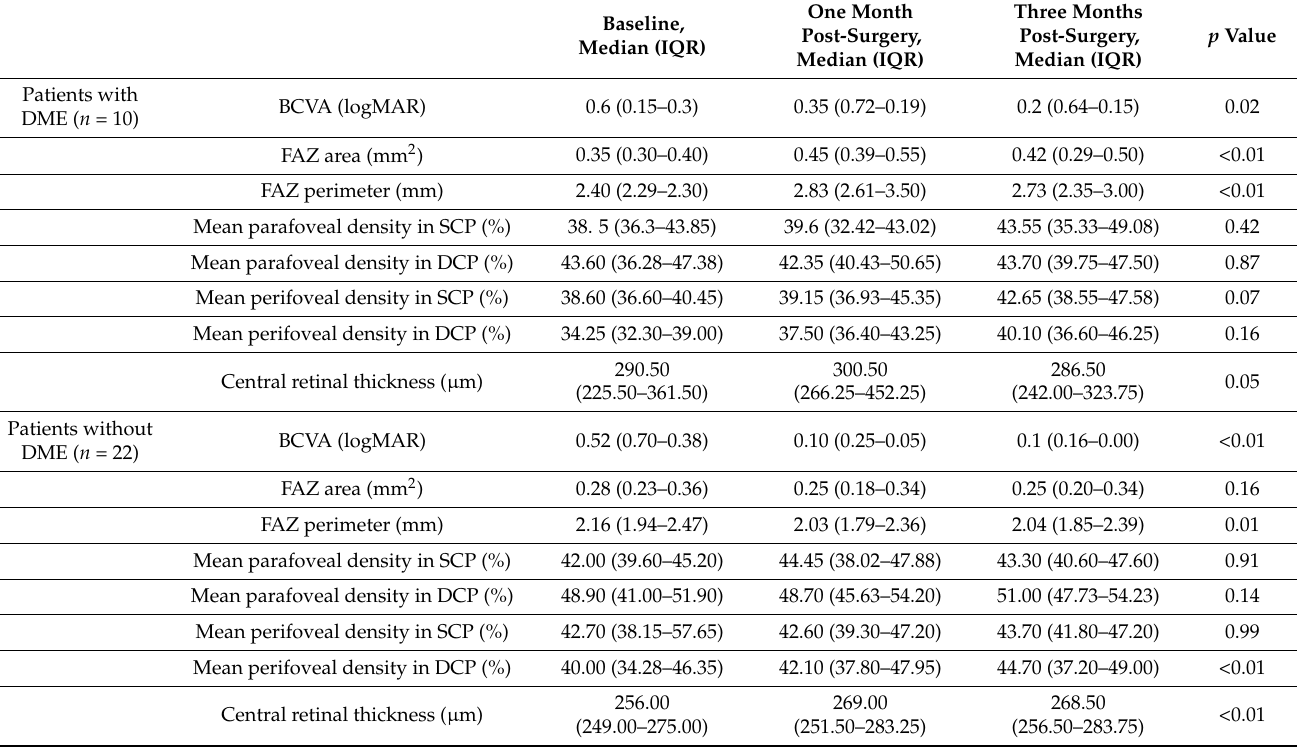
Table 4. Association between DME and the FAZ area in both groups at one and three months post- surgery.